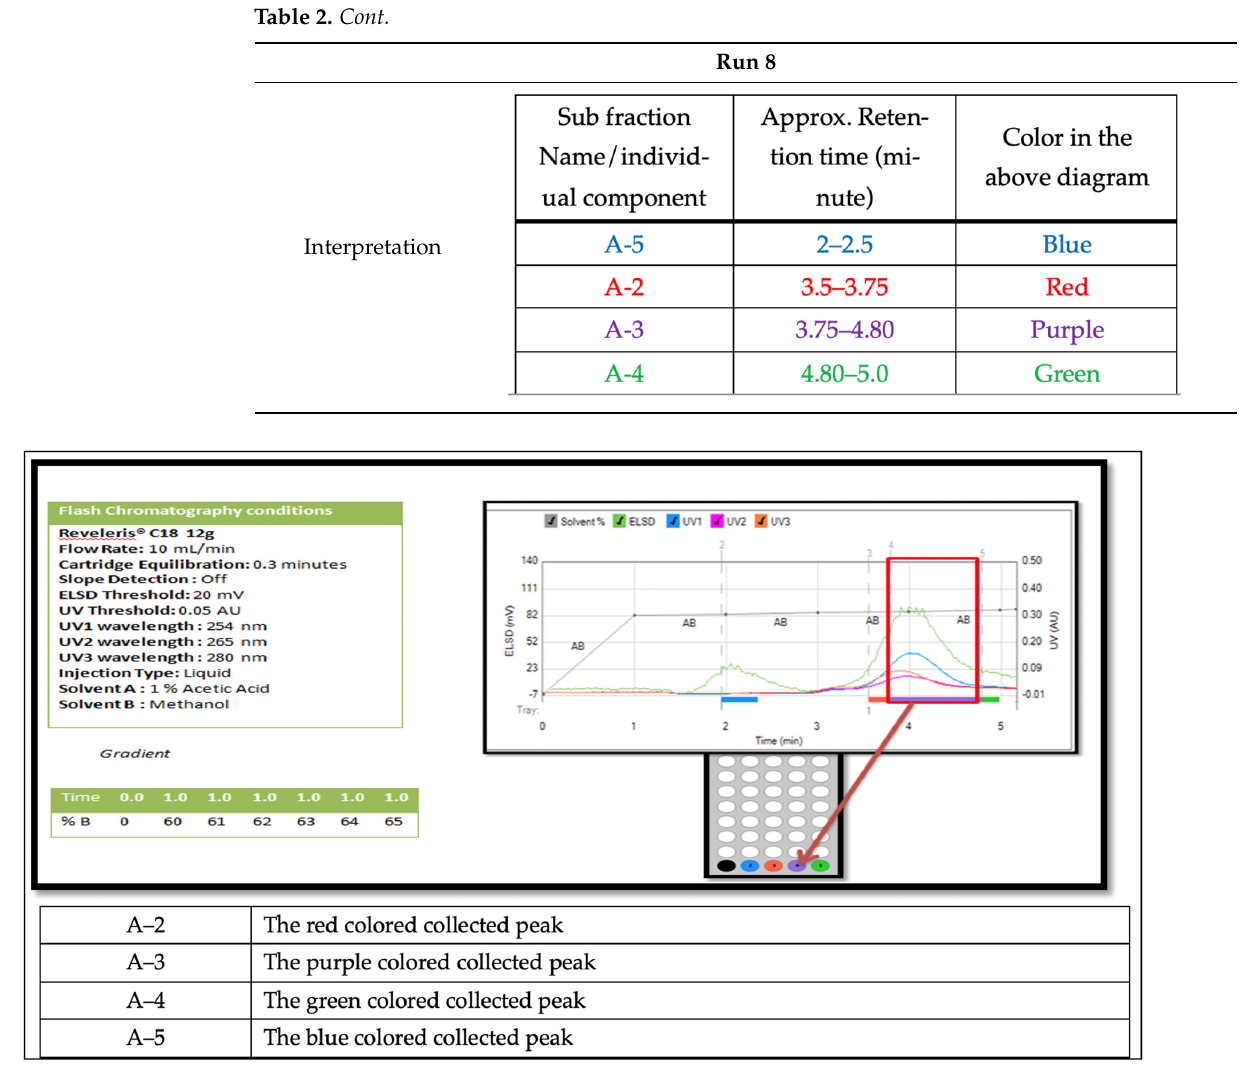
Figure 1. Demonstrates the isolated subfractions in the flash chromatogram of run 8 with color indicating the fractions separated.